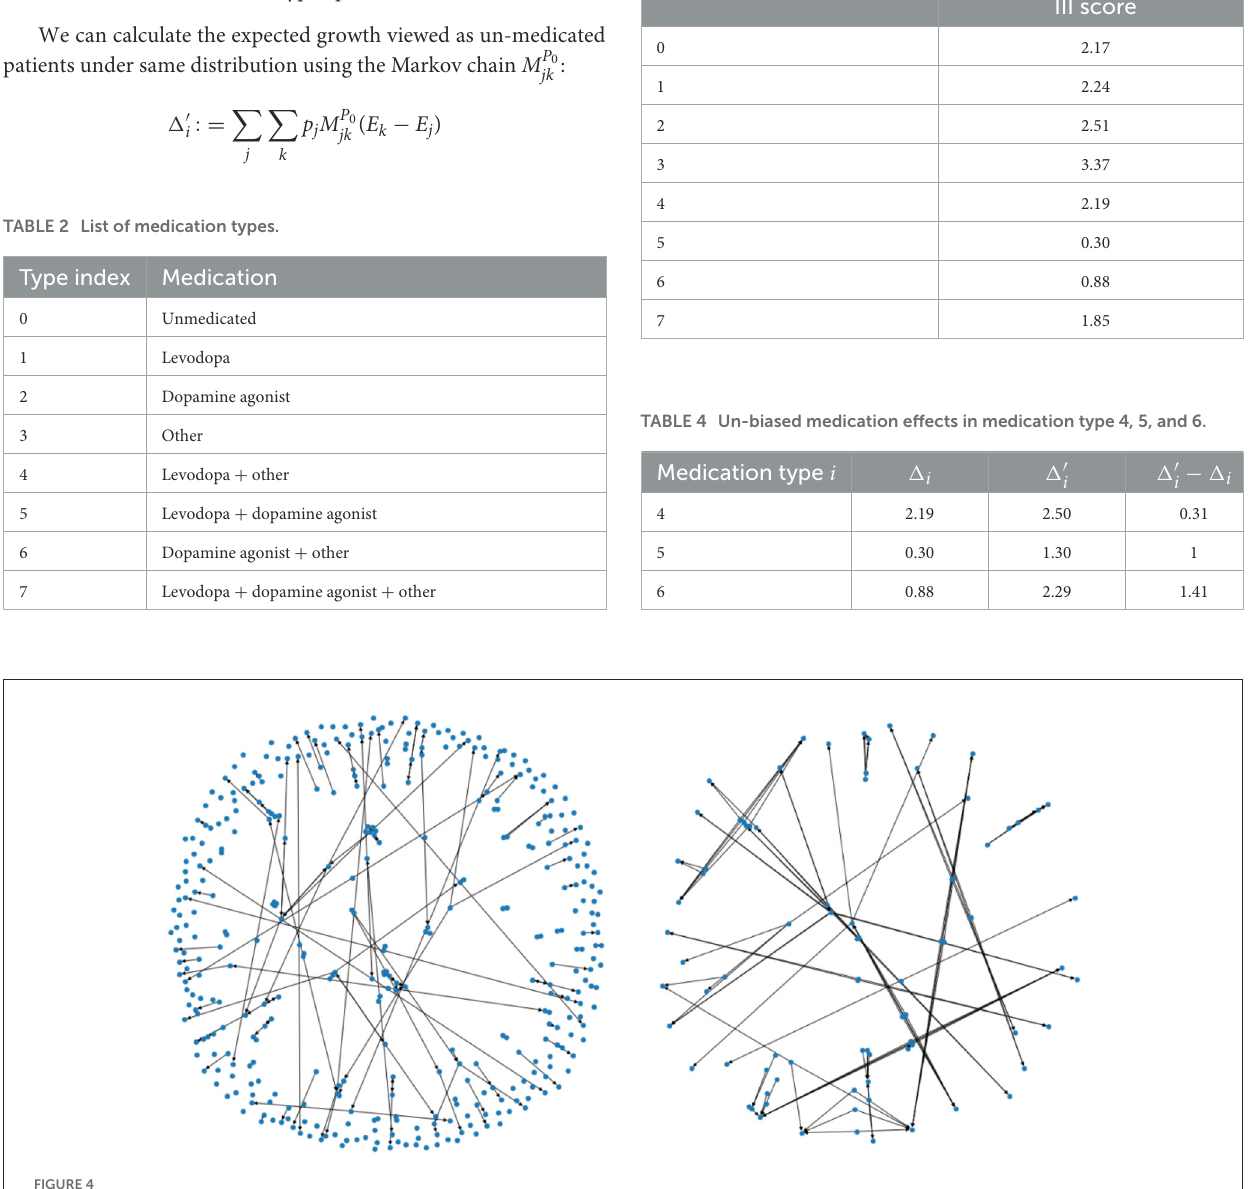
FIGURE4 The two figures illustrate two Markov chains associated with medication type 0 and 1, respectively. Its nodes are derived from the outputs of the mapper